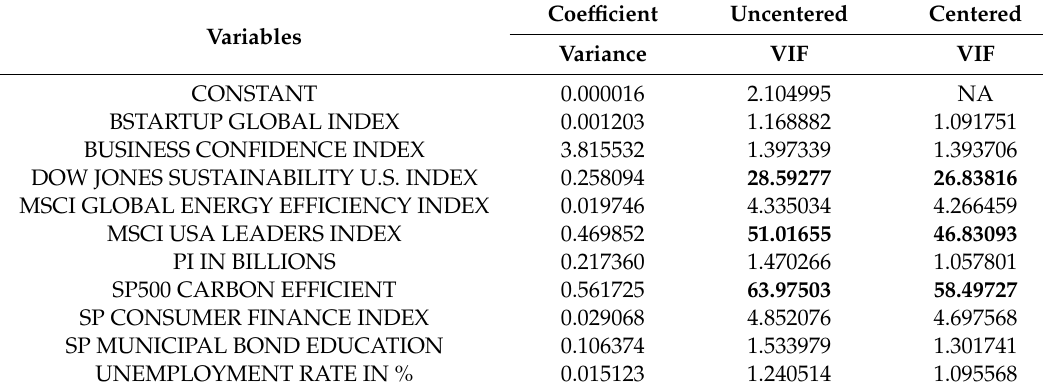
Table 1. Variance inflation factors (VIF) of the independent